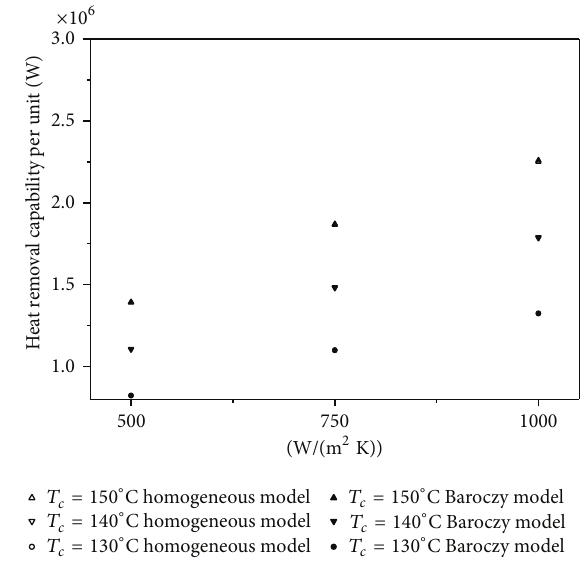
Figure 8: The heat removal capability per OLPCCS unit under different